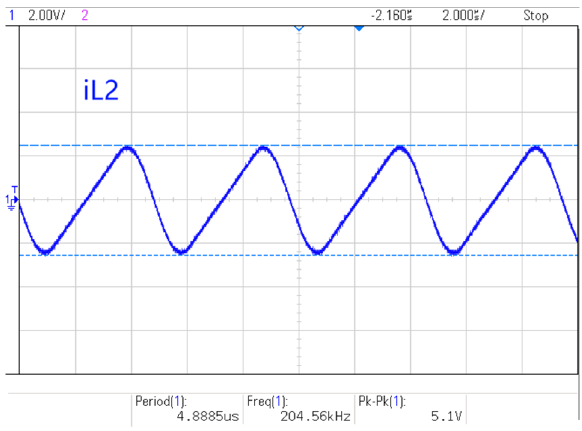
Figure 27. Traditional topological inductive current waveform.